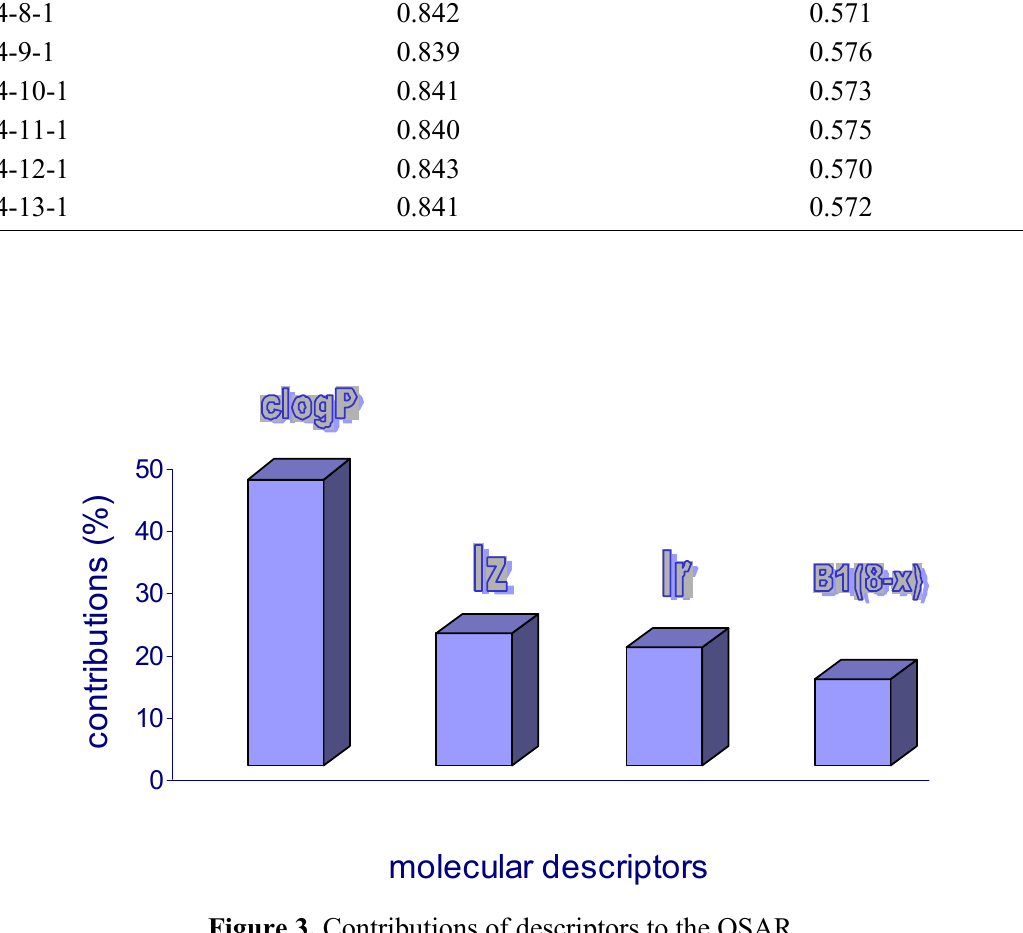
Figure 3. Contributions of descriptors to the